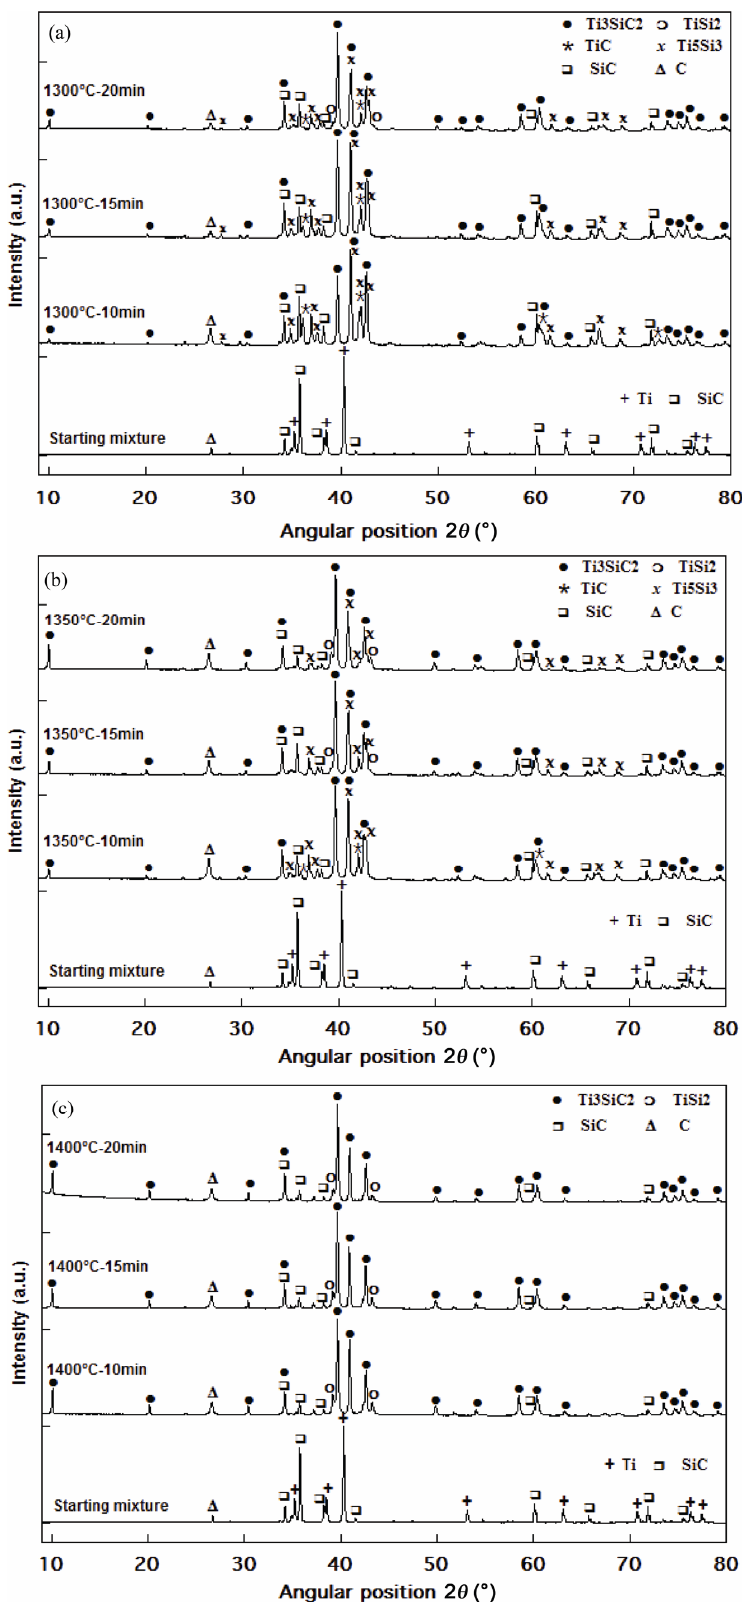
Fig. 4 XRD profiles of 3Ti/2SiC powder and samples sintered for different holding time (10, 15, and 20 min) in the studied temperature range of 1300–1400 ℃